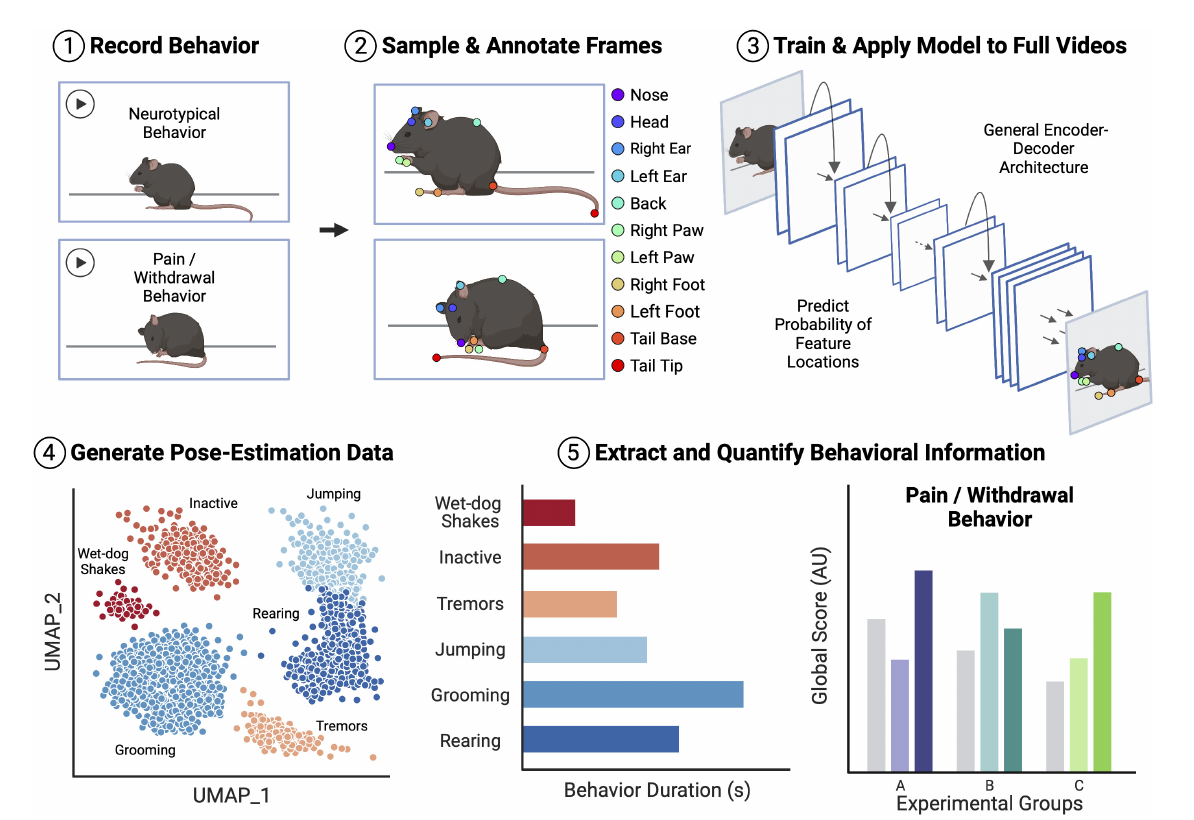
FIGURE1 Overview of an example workflow for deep learning (DL)-assisted automated pain/withdrawal behavioral analysis. Animal behavior is first recorded on video, including both neurotypical behavior and potential pain/withdrawal behavior. Distinct frames are then sampled from the video pool, and the points of interest in the frames are manually annotated. The labeled frames are then used to train an encoder-decoder convolutional neural network (CNN) with tools such as DeepLabCut or SLEAP. Once the model is trained and achieves a desired level of accuracy, the full videos are fed into the model to generate pose-estimation data for all mice. Finally, behavioral information is extracted from the estimated pose data and quantified ahead of statistical comparisons. This extracted behavioral information can then be fed into field-standard global scoring algorithms and models, thus allowing for comparison of pain/withdrawal behavior between control and experimental groups of mice. Importantly, there are many easily accessible and open-source tools for each step of the example analysis pipeline, many of which have been tested and validated in the context of translational pain and opioid abuse research. Figure created with